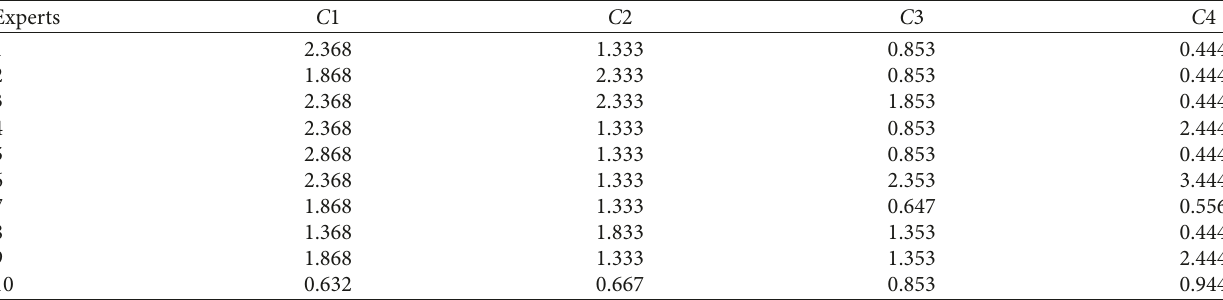
Table 10: The standardization matrix of the first-level index.